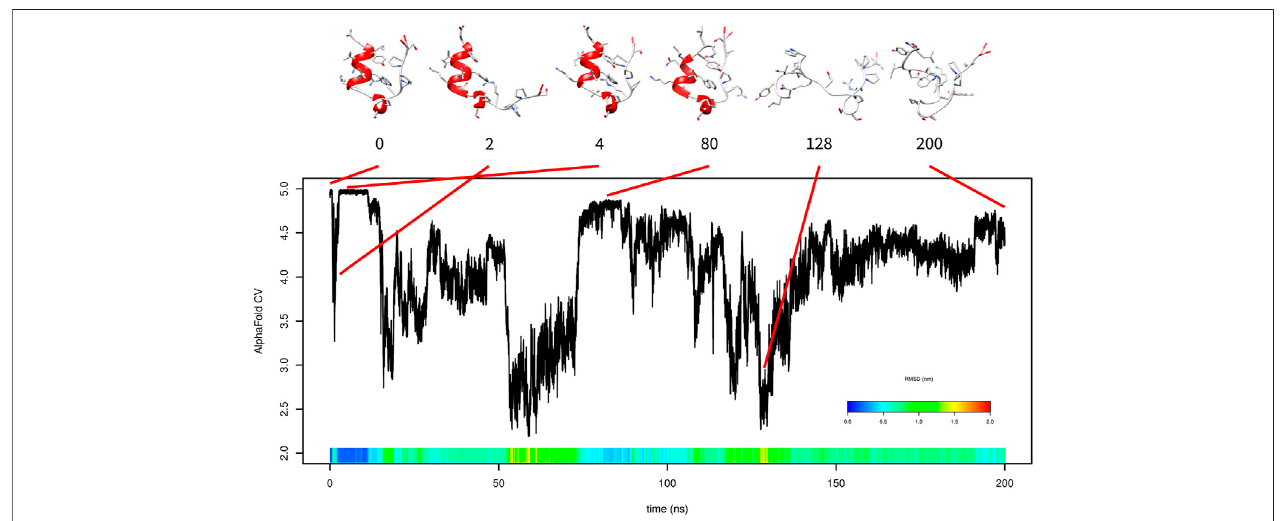
FIGURE 2 | Evolution of AlphaFold-based CV in metadynamics simulation of Trp-cage with AlphaFold-based CV with selected frames. RMSD is depicted in the color scale.